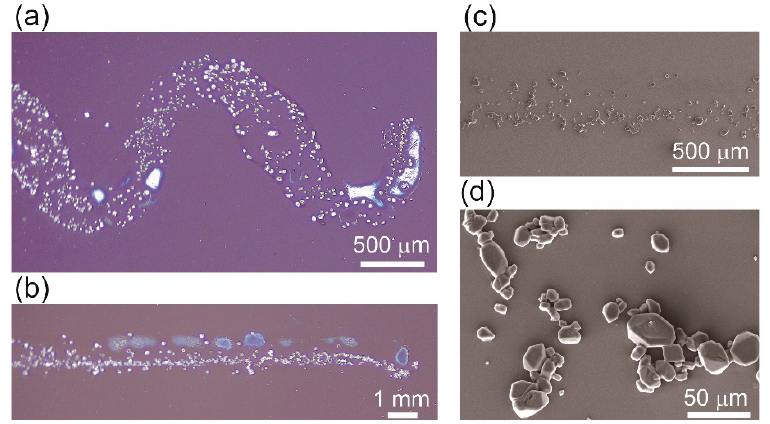
Figure 3. ( a , b ) RDX micro-patterns printed on a pristine Si-wafer surface. ( c , d ) SEM images of an RDX micro-pattern showing numbers of single RDX crystals in the pattern.